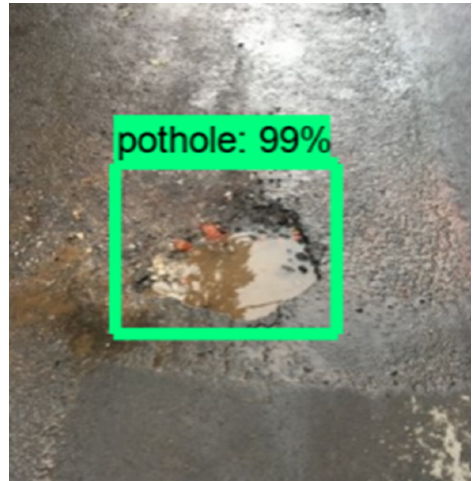
Figure 12. Detected pothole